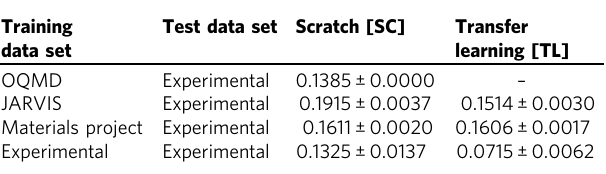
Table 3 Performance of ElemNet models on the experimental data in MAE